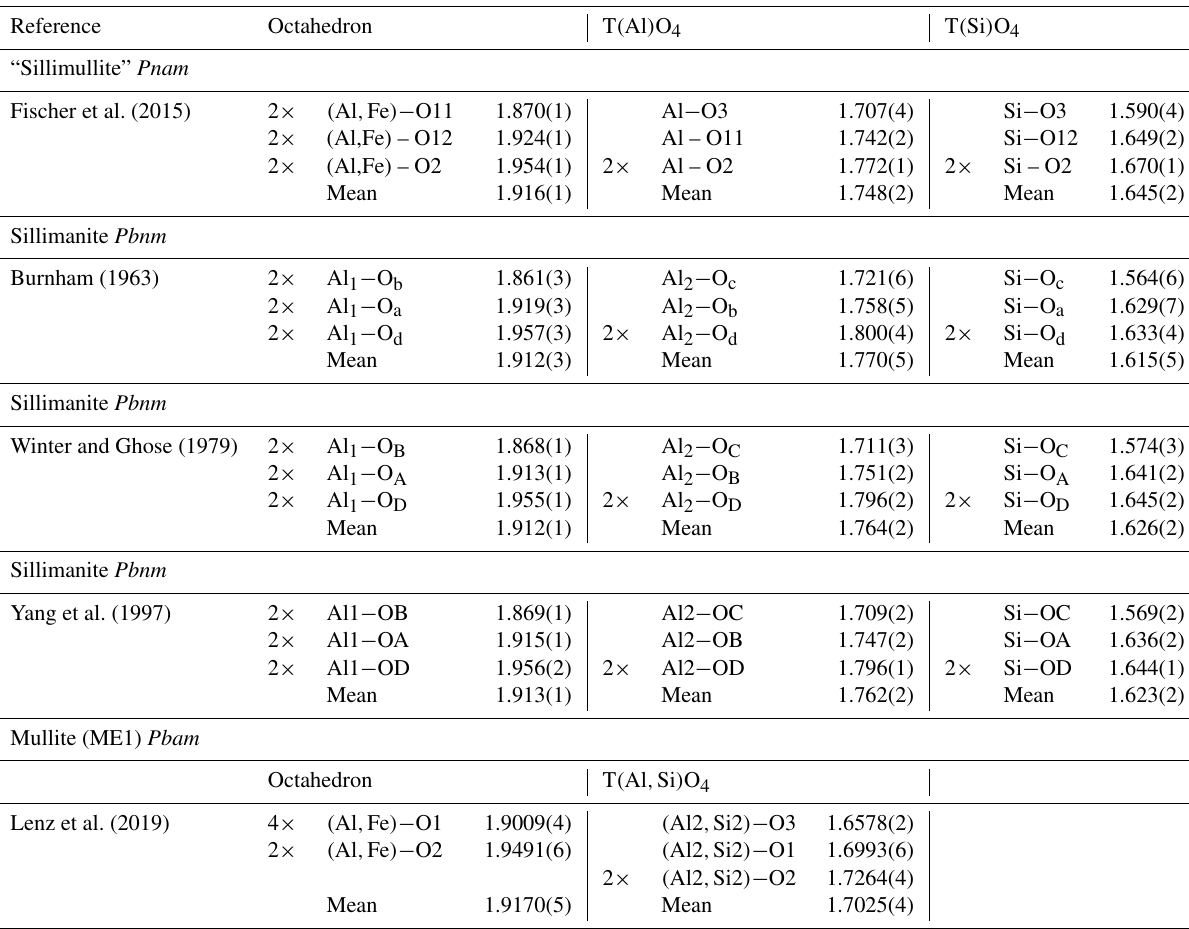
Table 6. Interatomic distances (Å) within the octahedra and TO 4 tetrahedra of “sillimullite”, sillimanite and natural mullite (for calculation of uncertainties of mean values, see Table